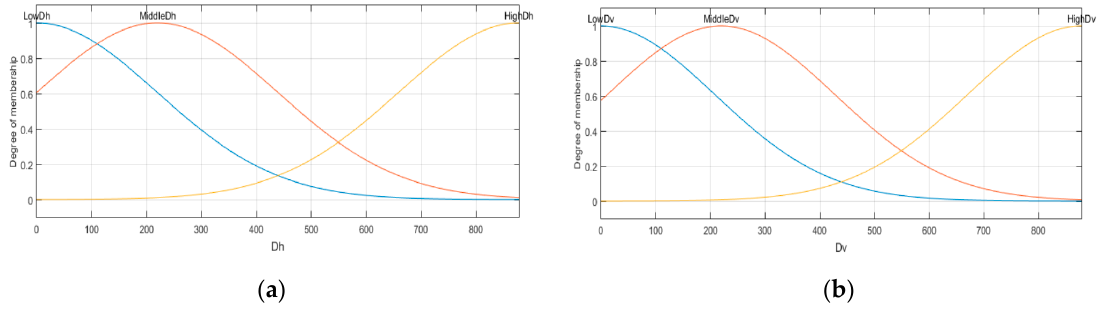
Figure 6. ( a ) Dh input MF ; ( b ) Dv input MF .